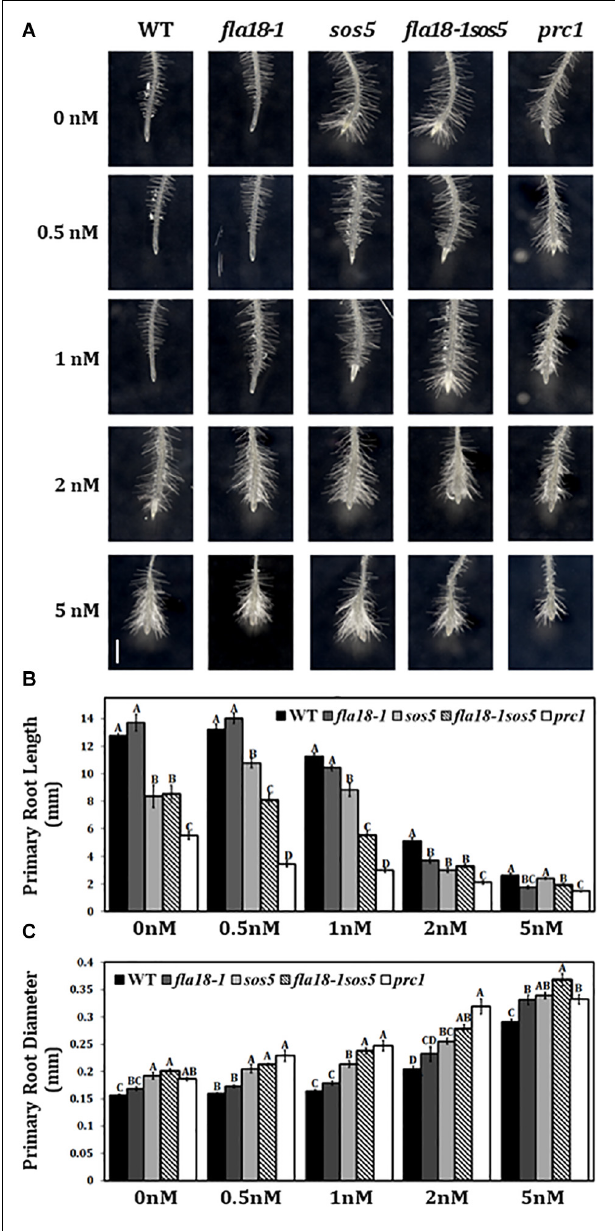
FIGURE 5 | fla18 and fla18sos5 are hypersensitive to the cellulose synthase inhibitor, Isoxaben. (A) Primary root tips of seedlings of the indicated genotypes were grown on MS medium with 1% sucrose for 4 days and then transferred to medium containing 1% sucrose and the indicated concentration of isoxaben, for 48 h. (B,C) Measurements of PR length (B) and diameter (C) at the end of the experiment. The results were analyzed using JMPpro13 for statistical analysis and run through Tukey’s HSD test ( p < 0.05 ). Error bars represent SE. PR length: n = 6 ( prc1 ; n = 5). PR diameter: n = 4. Scale bar = 1 mm (A)